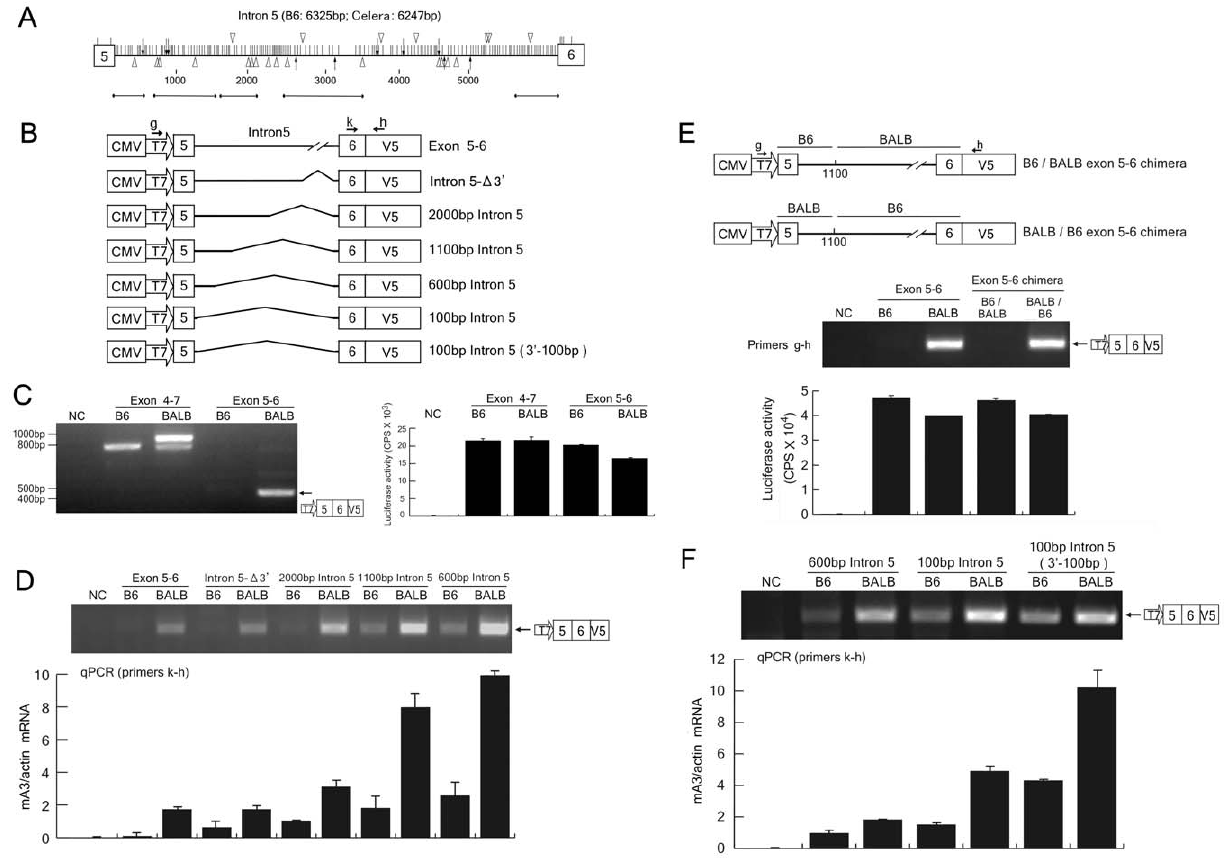
Figure 5. The effect of exon 5 and its downstream sequences on mA3 intron 5 splicing. (A) Distributions of sequence polymorphisms in the intron 5 of the Apobec3 gene locus between the B6 allele [NT_039621] and the Celera database sequence of mixed mouse DNA [NW_001030577.1]. Shorter horizontal lines below the thick one representing intron 5 indicate regions of sequenced BALB/c genome [DDBJ accession No. AB646261-AB646265], which show nucleotide sequences identical to corresponding Celera database sequences. Spans of the analyzed